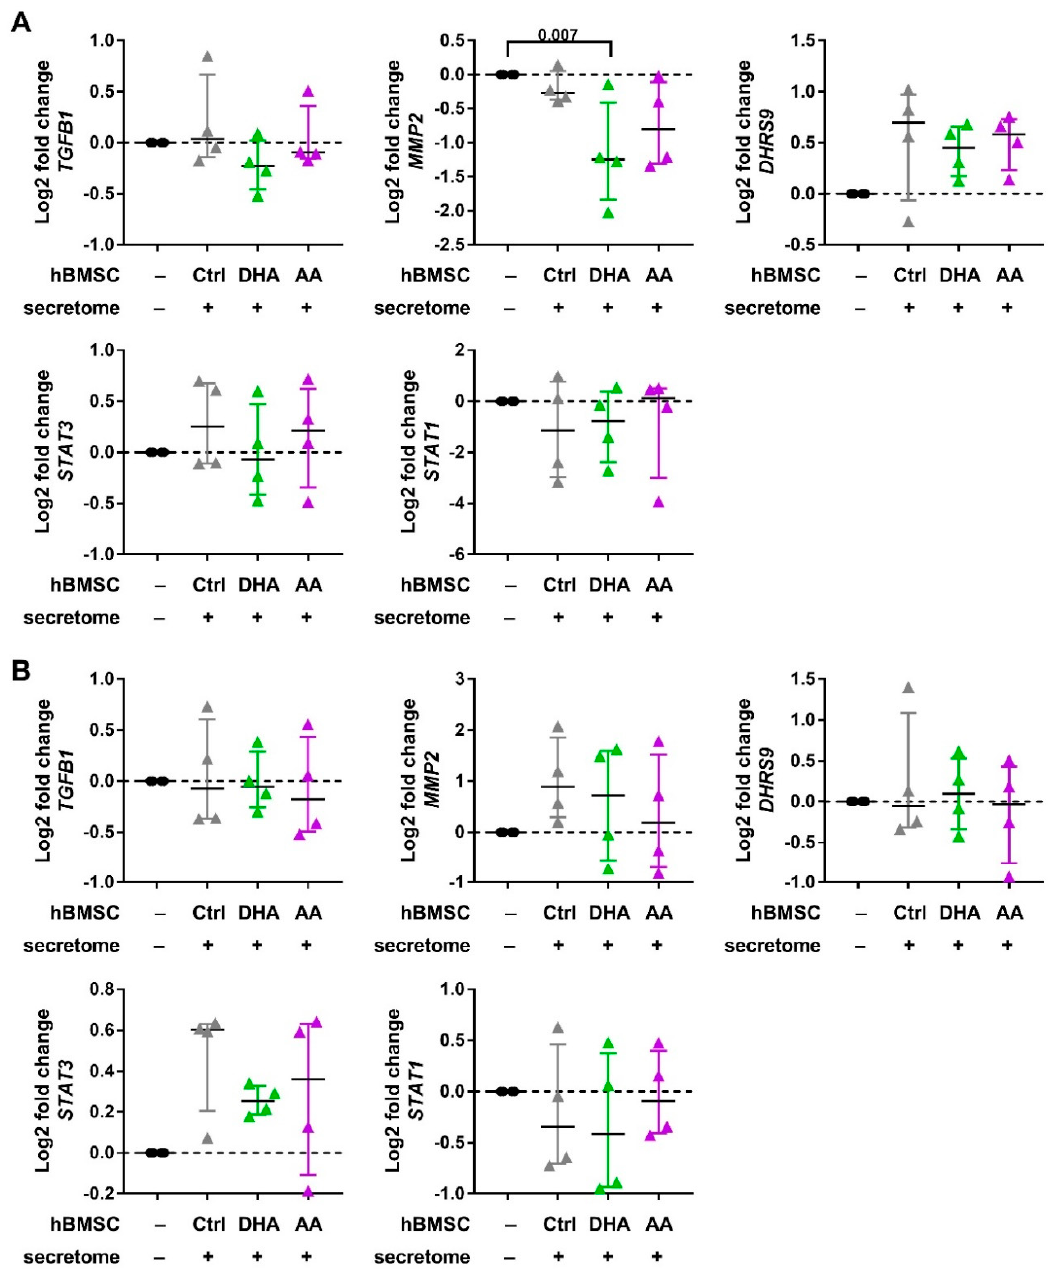
Figure 5. The effect of hBMSC secretome on the gene expression of Mreg-polarized and Mreg-activated macrophages. The gene expression of macrophage phenotype markers was investigated with QPCR. The effect of hBMSCs on ( A ) Mreg-polarized and ( B ) Mreg-activated macrophages is visualized with log2 fold changes calculated against macrophages cultured without hBMSCs (represented by the zero line) for each individual donor. The differences among groups were determined with Kruskal-Wallis rank sum test and post hoc using Dunn’s test. The results are expressed as medians with interquartile ranges; n = 4 biological replicates. Ctrl, control; DHA, docosahexaenoic acid; AA, arachidonic acid.